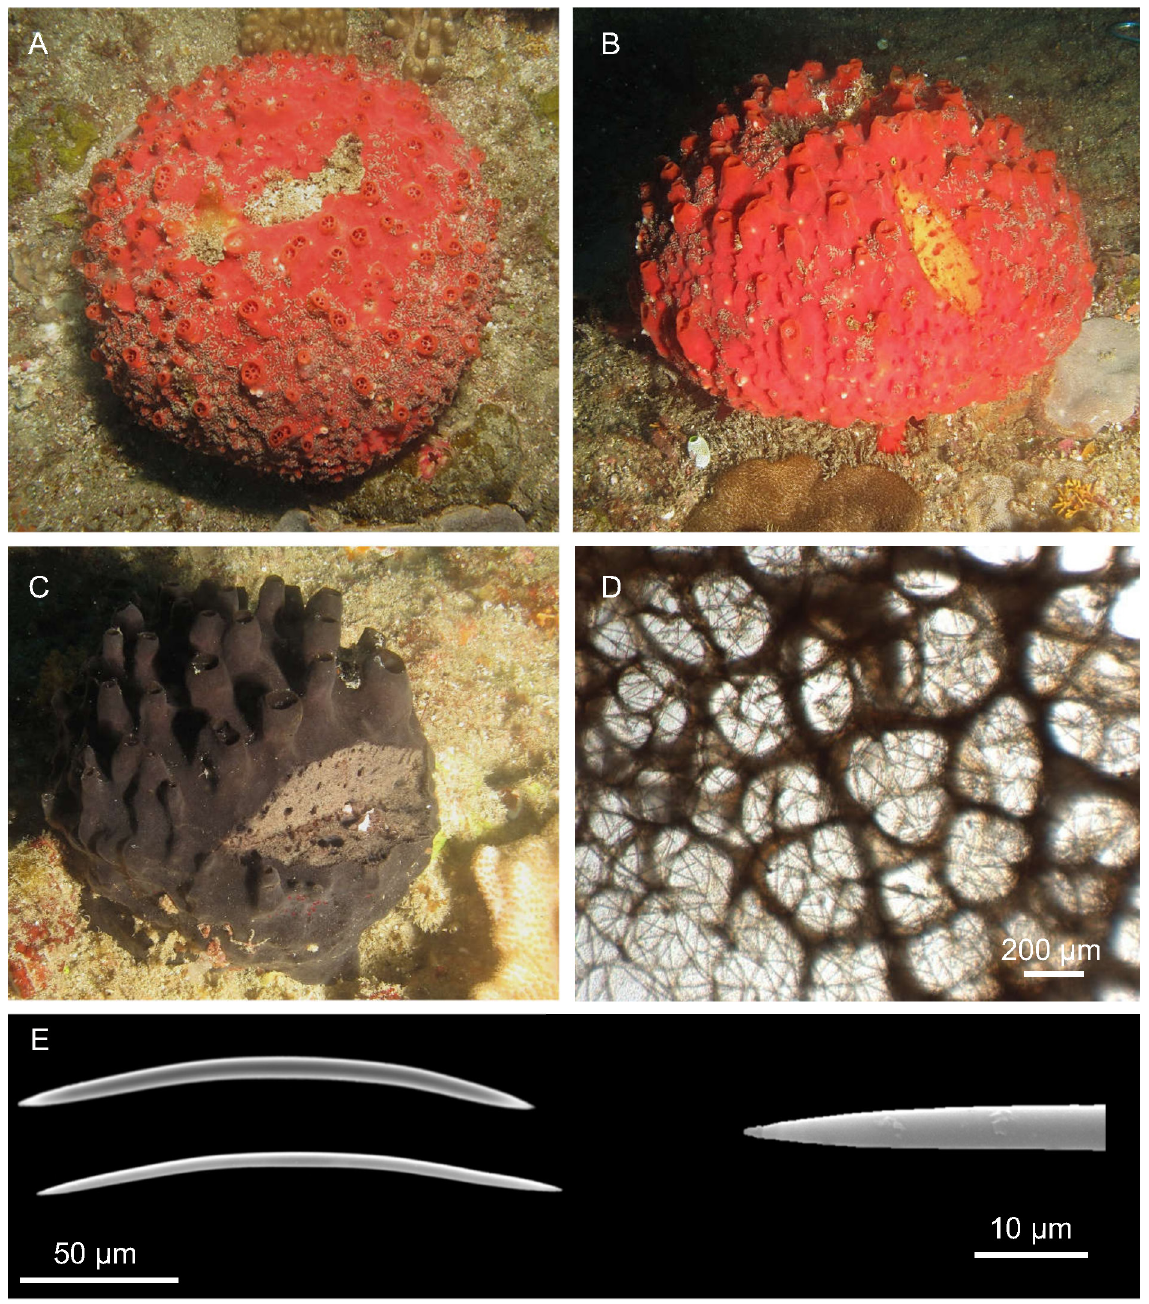
Fig. 11. Oceanapia ramsayi Lendenfeld, 1888. A–B . Red specimen in situ (PdO27); in B a fresh cut highlights the yellow choanosome. C . Brown specimen (PdO28). D . Choanosomal skeleton. E . Oxeas and magnification of a